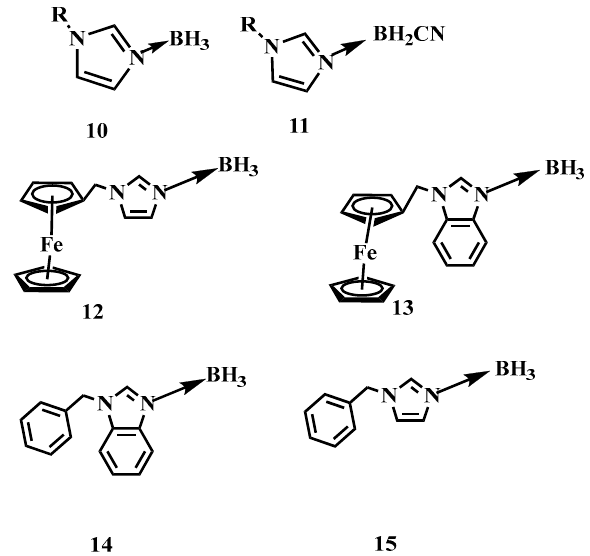
Figure 2. The structure of N -alkyl imidazole borane, N -alkyl imidazole cyanoborane, N -(aryl- methylene)-benzimidazole borane and N -(arylmethylene)-imidazole borane [14–16].